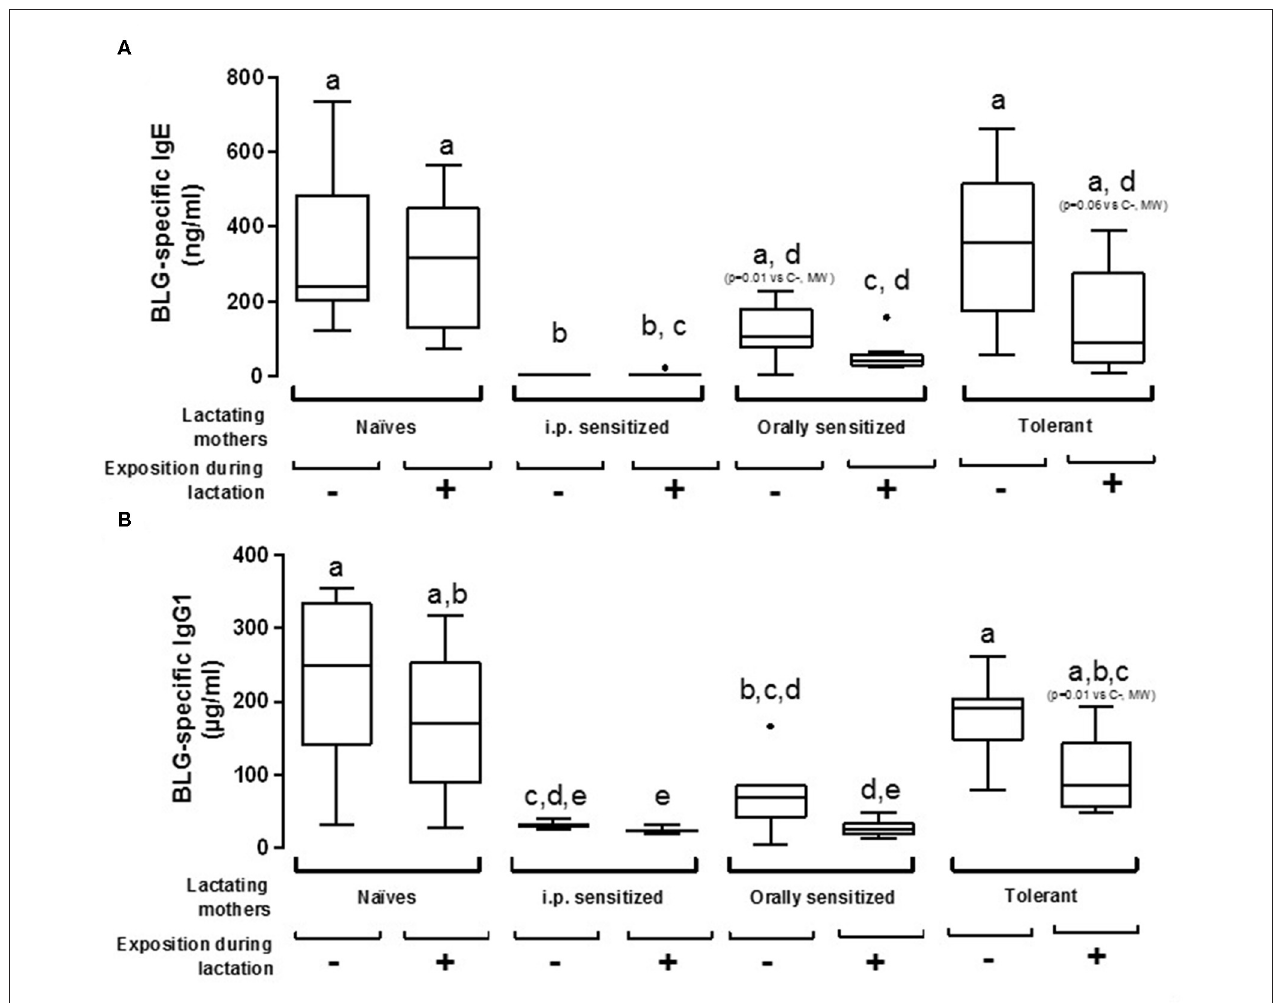
FIGURE 3 | Plasma BLG-Specific IgE (A) and IgG1 (B) antibodies induced after one i.p. sensitization with BLG/alum in pups fostered by naïve or pre-natally sensitized or tolerated mothers, further orally exposed ( + ) or not (–) to BLG during lactation. Tukey box and whiskers from 7 to 8 mice/groups are shown. Statistical analysis evidenced differences between groups ( p < 0.0001, non-parametric Kruskall Wallis test). Pairwise multiple comparisons were then performed using Conover-Iman testing, including Bonferroni correction for multiple testing. Groups indicated with different letters are different from each other’s ( p < 0.05). p -values obtained using additional testing against control (naive and non-exposed mothers) by Mann Whitney test are also indicated between